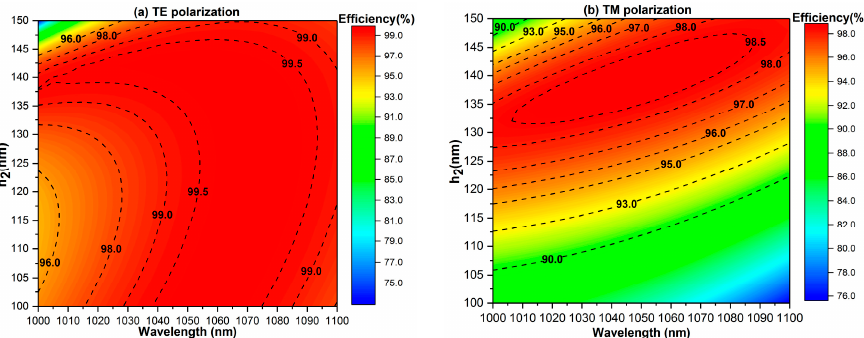
Figure 7. Tolerance analysis of the thickness of silicon layer. − 1st order diffraction efficiency versus incident wavelength and h 2 for ( a ) TE and ( b ) TM polarizations.